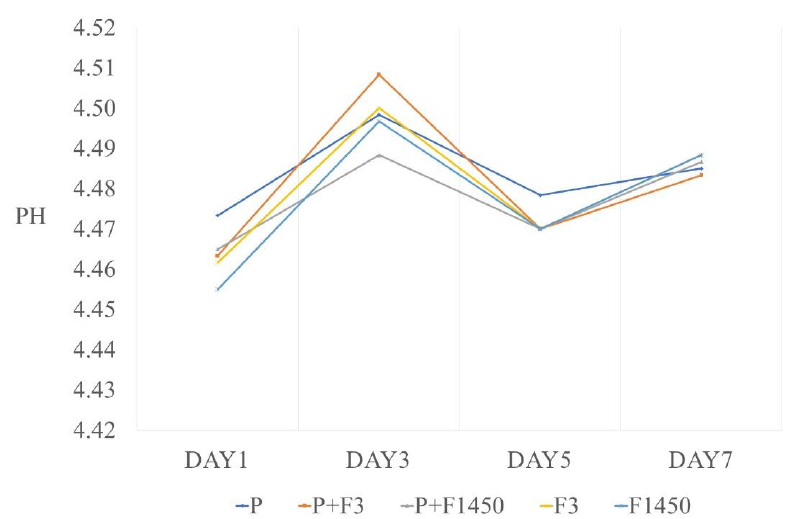
Figure 5. pH value of the demineralization solution after pH cycling. The x -axis indicates the elapsed time in days of the experiment.